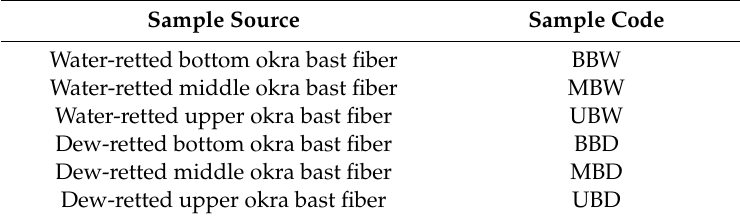
Table 1. Sample codes.